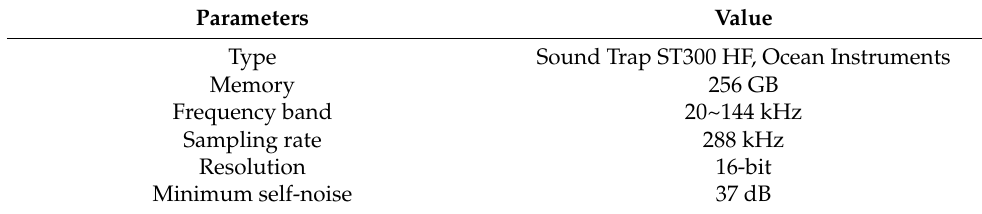
Table 1. Parameters of the hydrophone for data